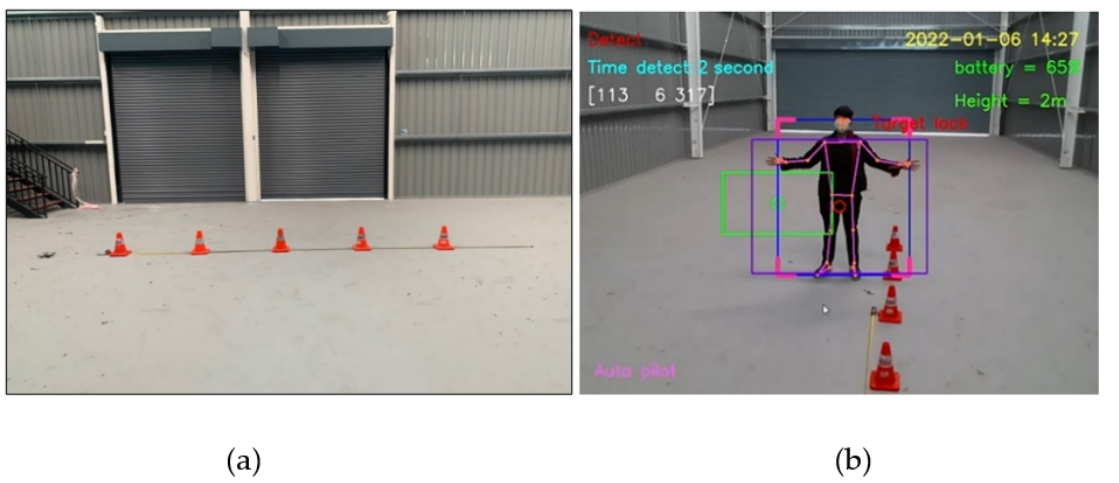
Figure 14. Experiments to discover proper distances between a drone and a person: ( a ) each traffic cone is equally far away (1 m separation); and ( b ) example experimental